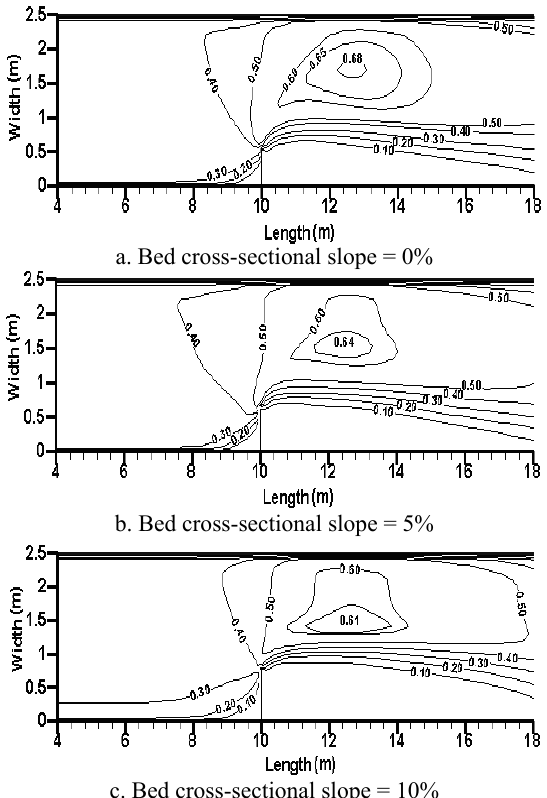
Fig.9 Isolines of velocities at z=+0.2m for the vertical